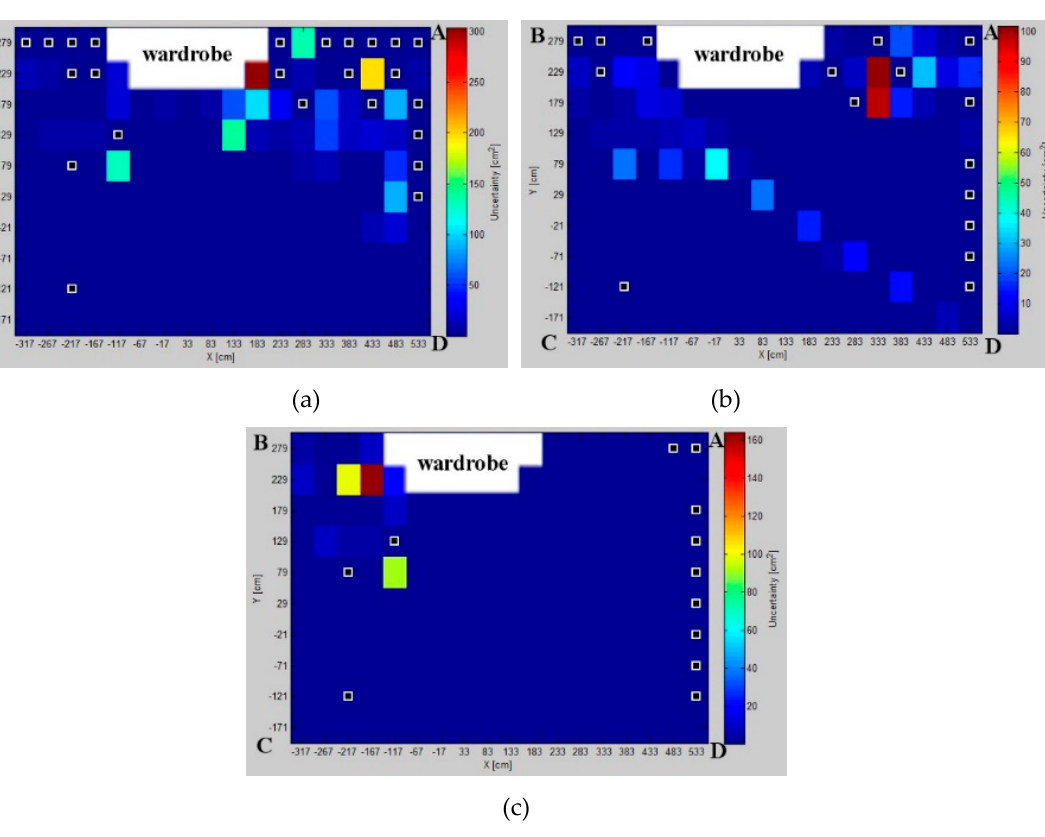
Figure 13. Standard error distributions for pairs: ( a ) AB ; ( b ) BD ; and ( c ) AD . Sampled positions with white frame markers show the sampling points with gross error.